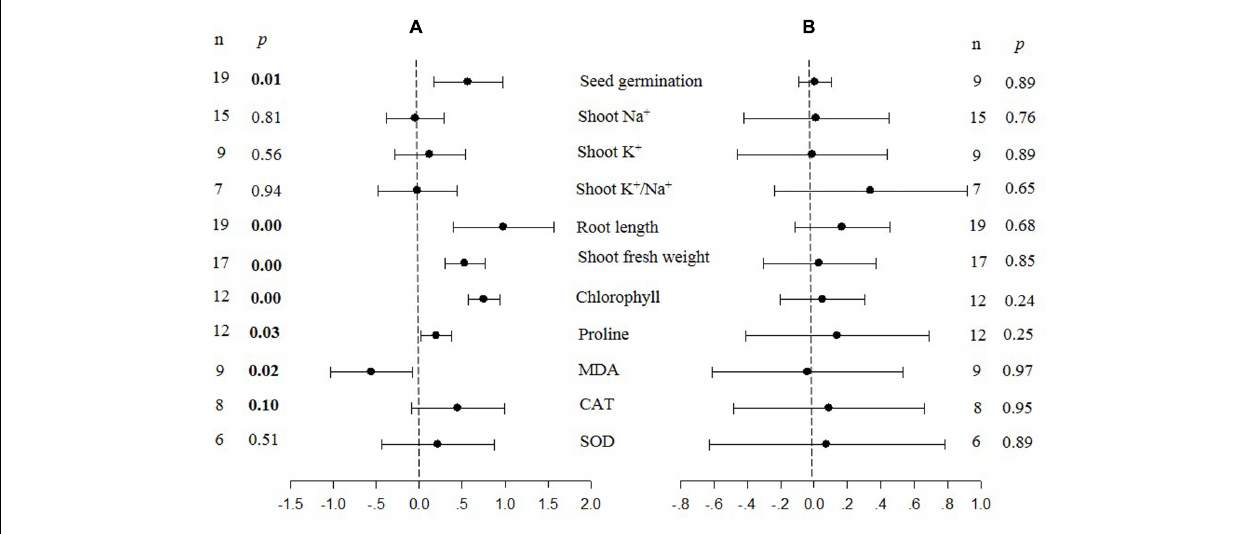
FIGURE 1 | Weighted summary effect sizes (ln R ) and 95% confidence intervals (CIs) for the effect of CIPK overexpression in transgenic plants subjected to NaCl stress conditions (A) and non-stress conditions (B). A p ≤ 0.05 indicates that the moderator level was significantly different than zero; n stands for the number of